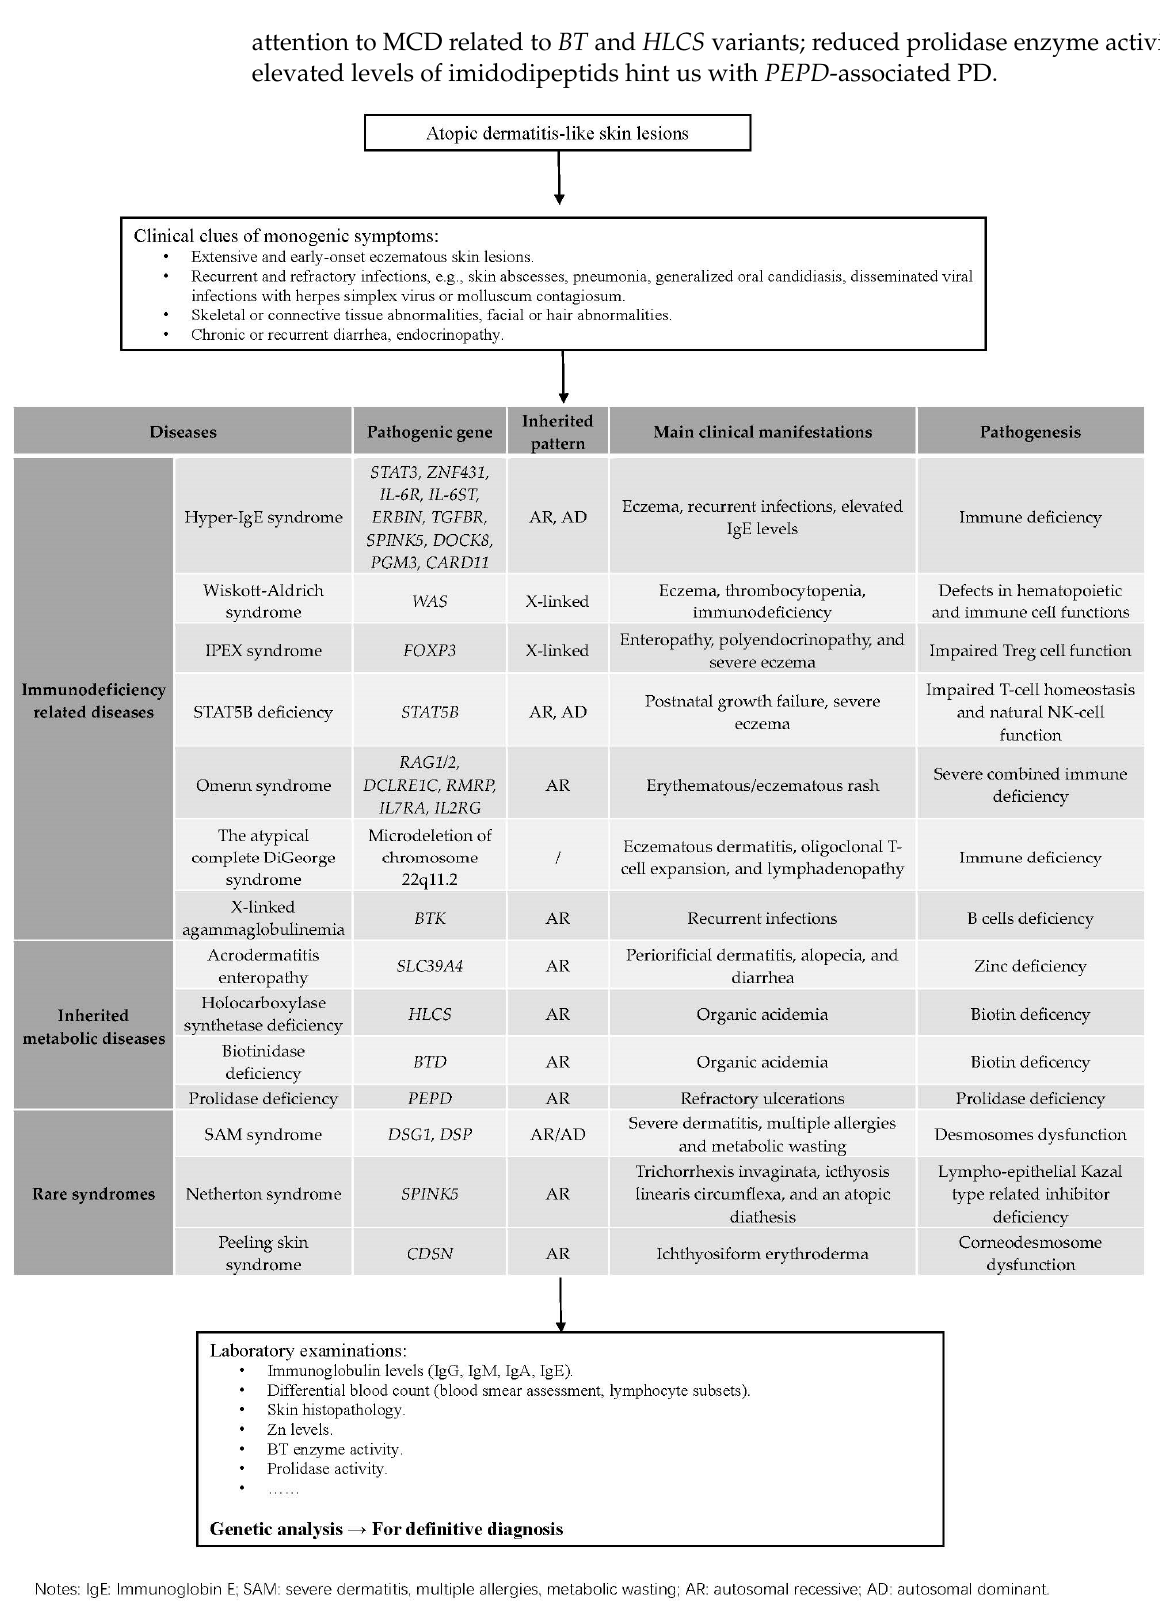
Figure 1. How to distinguish diseases performed with atopic dermatitis-like lesions.